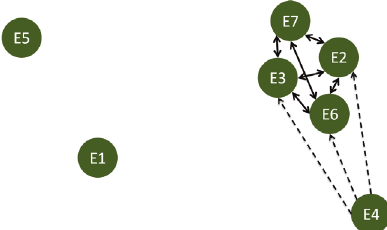
Figure 5: Illustrative dataset for RF-ML . If one con- siders k = 3 nearest neighbors, the instance E 4 has 3 (three) nearest neighbors, but no mutual nearest neighbor ( k (cid:6) =